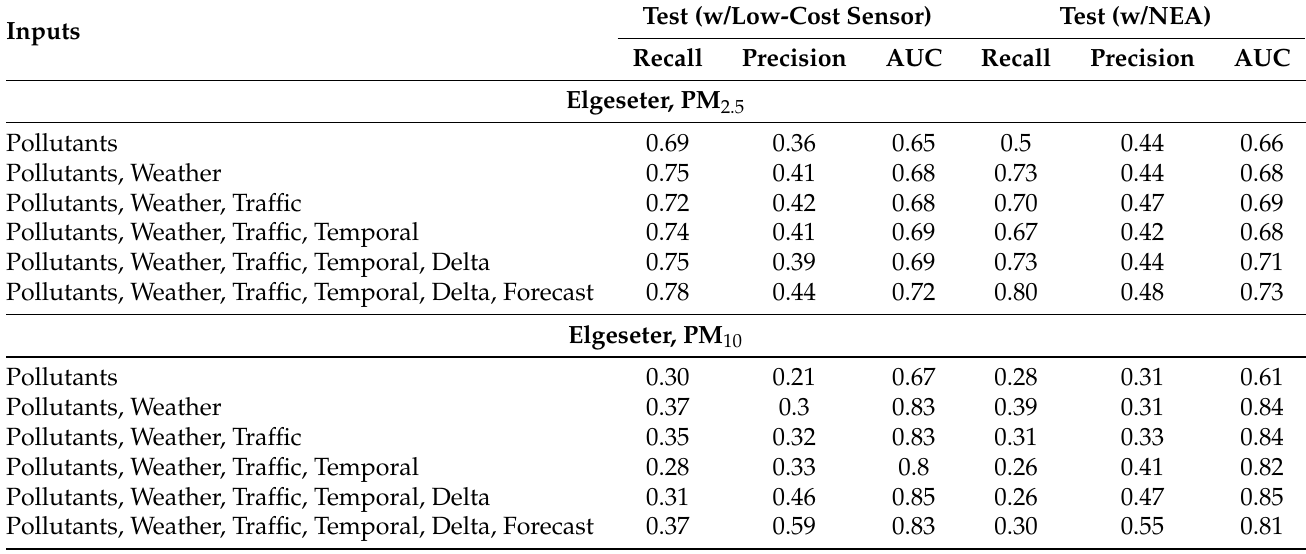
Table 6. Results for prediction of air quality levels with low-cost sensor data (calibrated) and NEA as input. Data